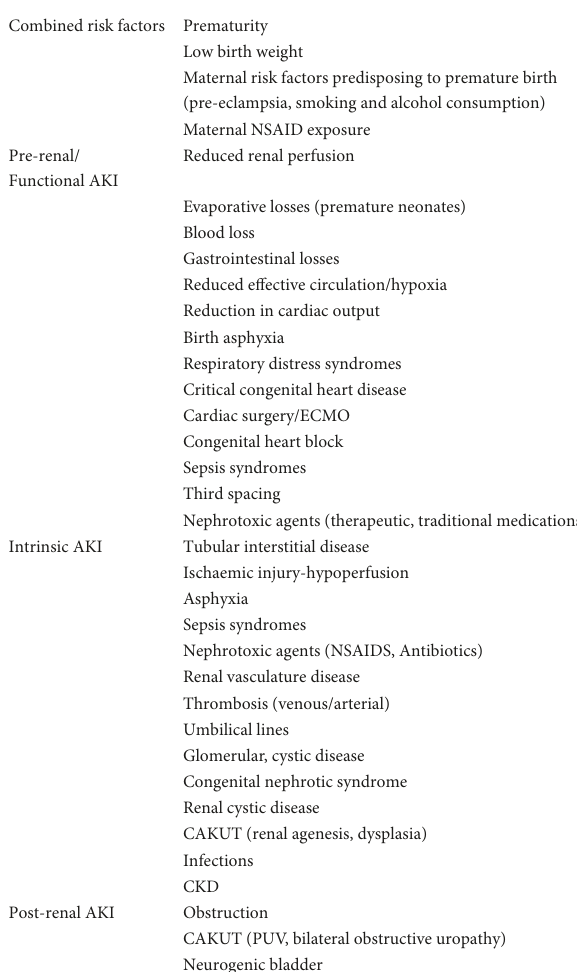
TABLE 2 Causes of neonatal